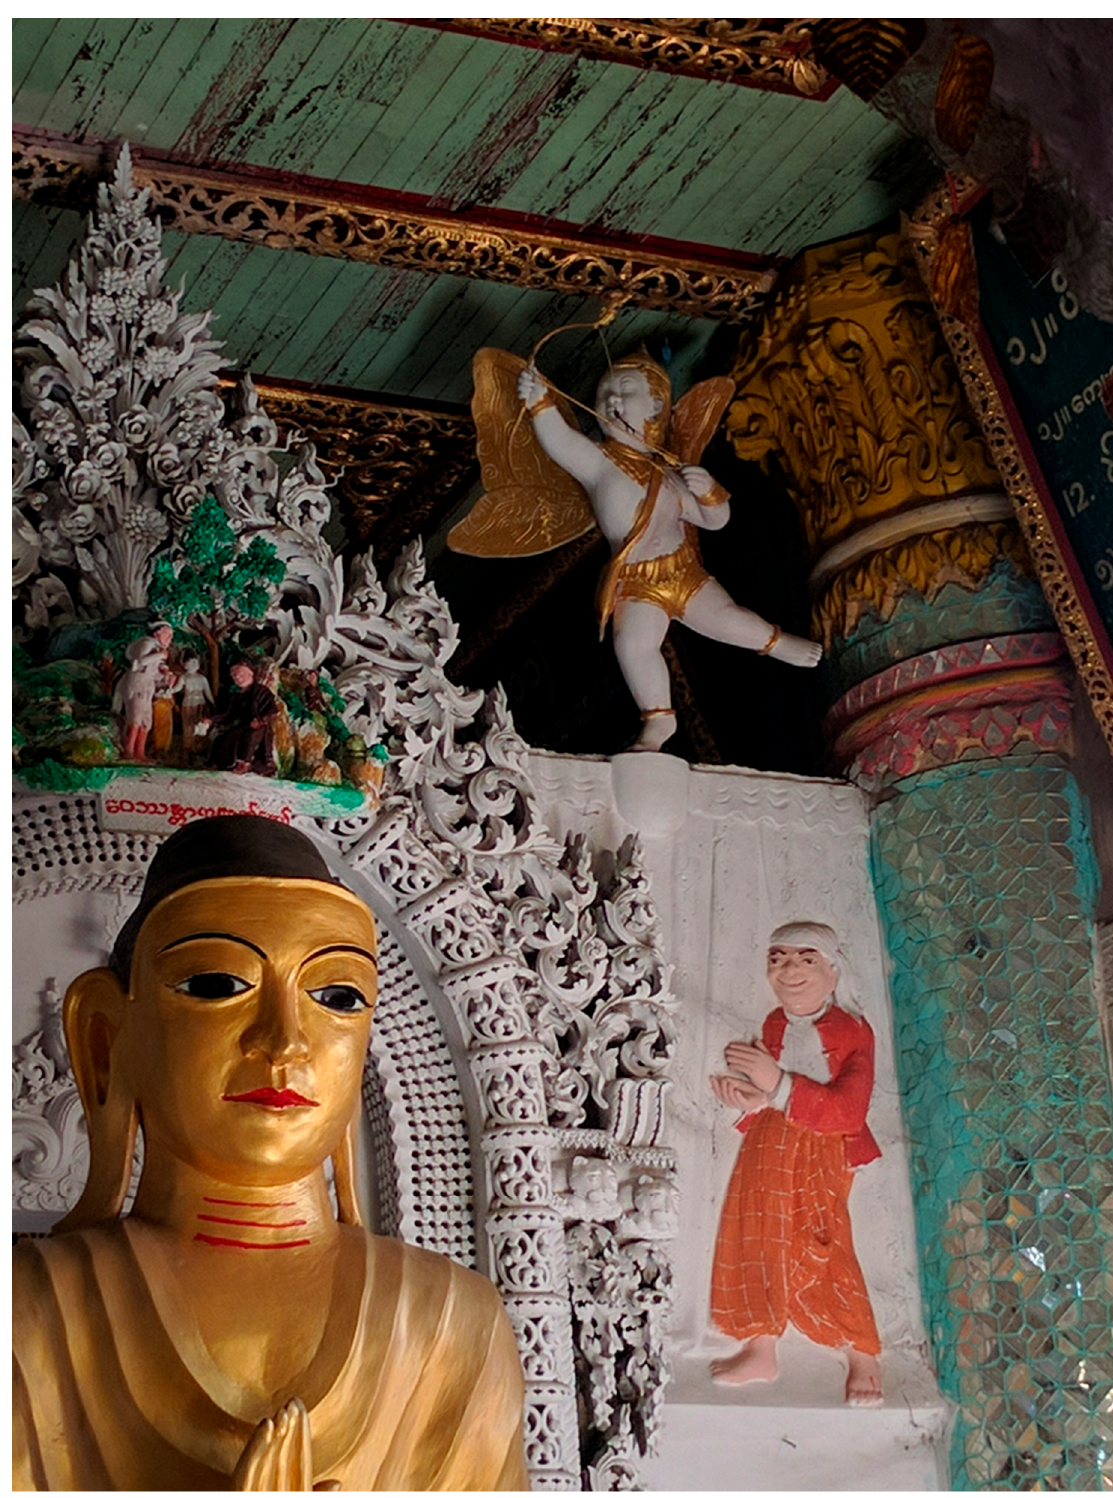
Figure 6. Photograph of the inside of the Arlein Nga Sint Pagoda.